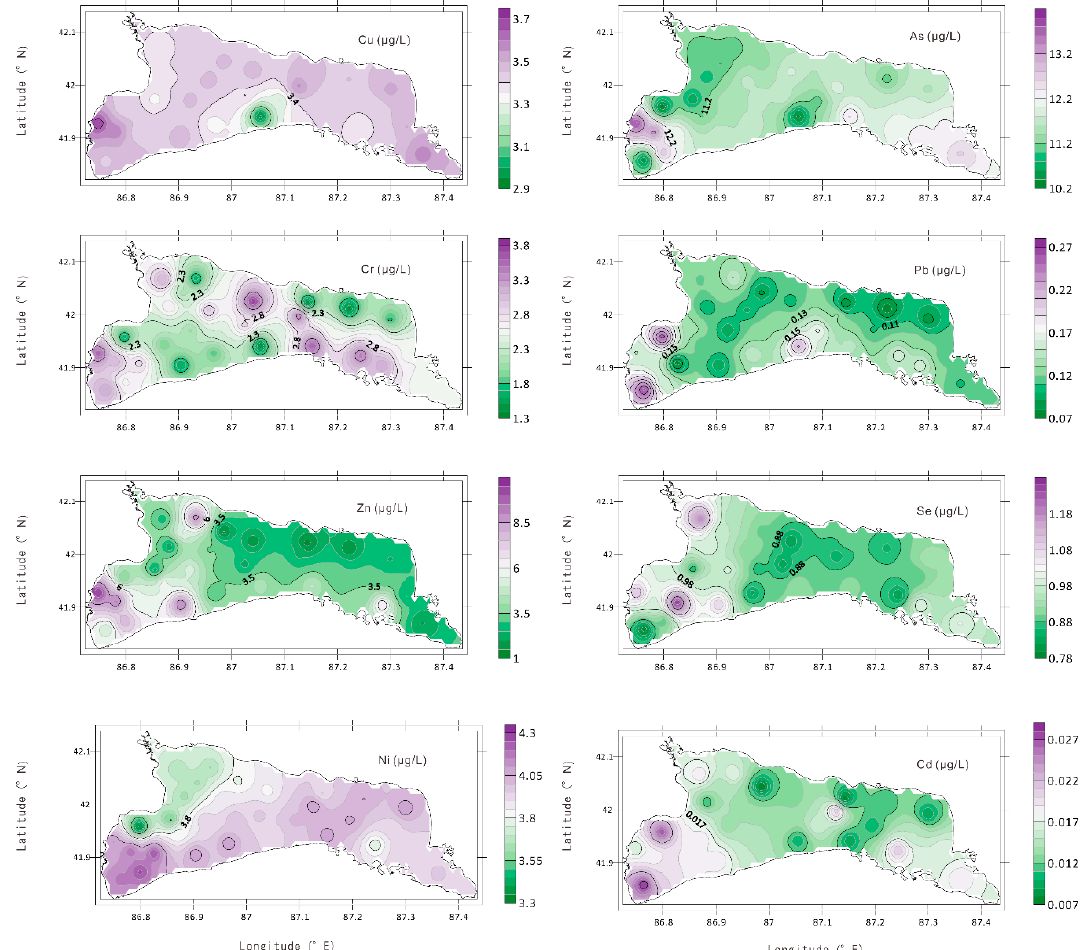
Figure 10. Spatial distribution maps of PTEs in Bosten Lake water.